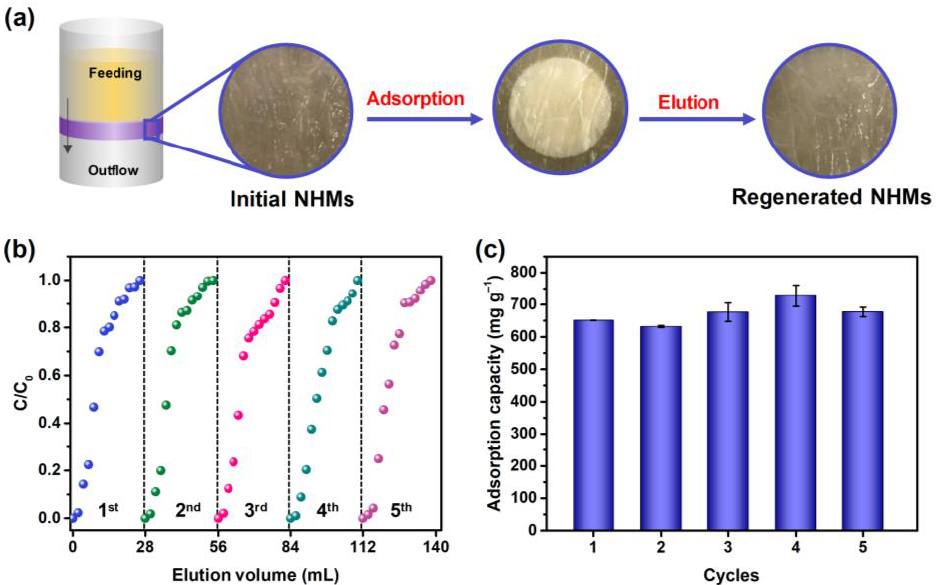
Figure 9. ( a ) Schematic diagram and photograph of the NHMs under different adsorption states during dynamic cycle tests. ( b ) The representative cycling breakthrough curves and ( c ) dynamic adsorption capacity of the thin-layer chromatography column packed with three layers of NHMs in five cycles.